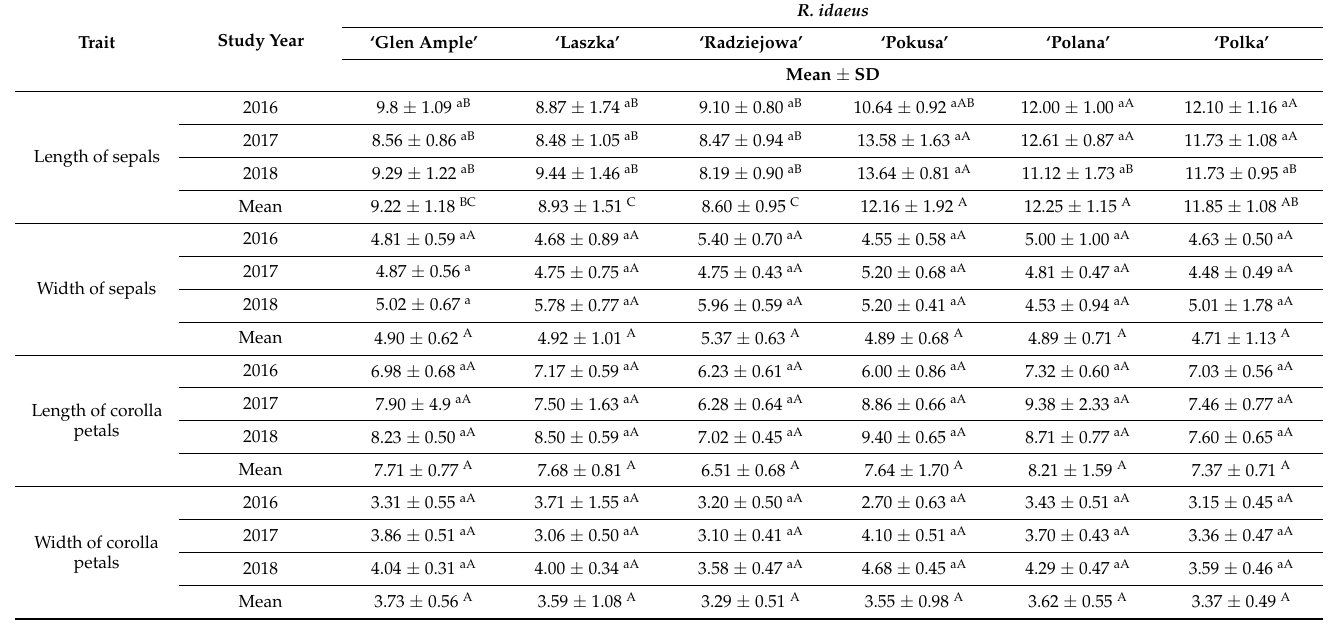
Table 1. Size of the perianth in six R. idaeus cultivars